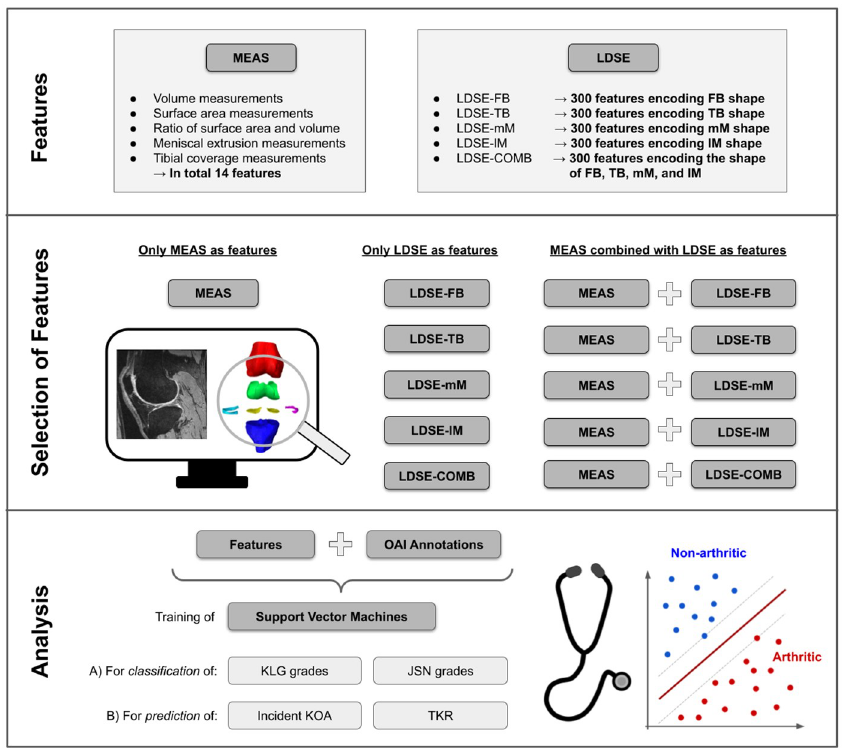
Fig 4. Selection of KOA features and performed analysis. Top: Computation and determination of suitable features. Middle: Selection of features for further analyses. Chosen are either all features of MEAS, or LDSE-FB/LDSE-TB/ LDSE-mM/LDSE-lM features encoding one anatomy, LDSE-COMB features encoding all anatomies, or MEAS combined with one kind of LDSE features. Bottom: Quantitative analysis of the suitability of selected features as KOA biomarkers by training of support vector machines for classification and prediction